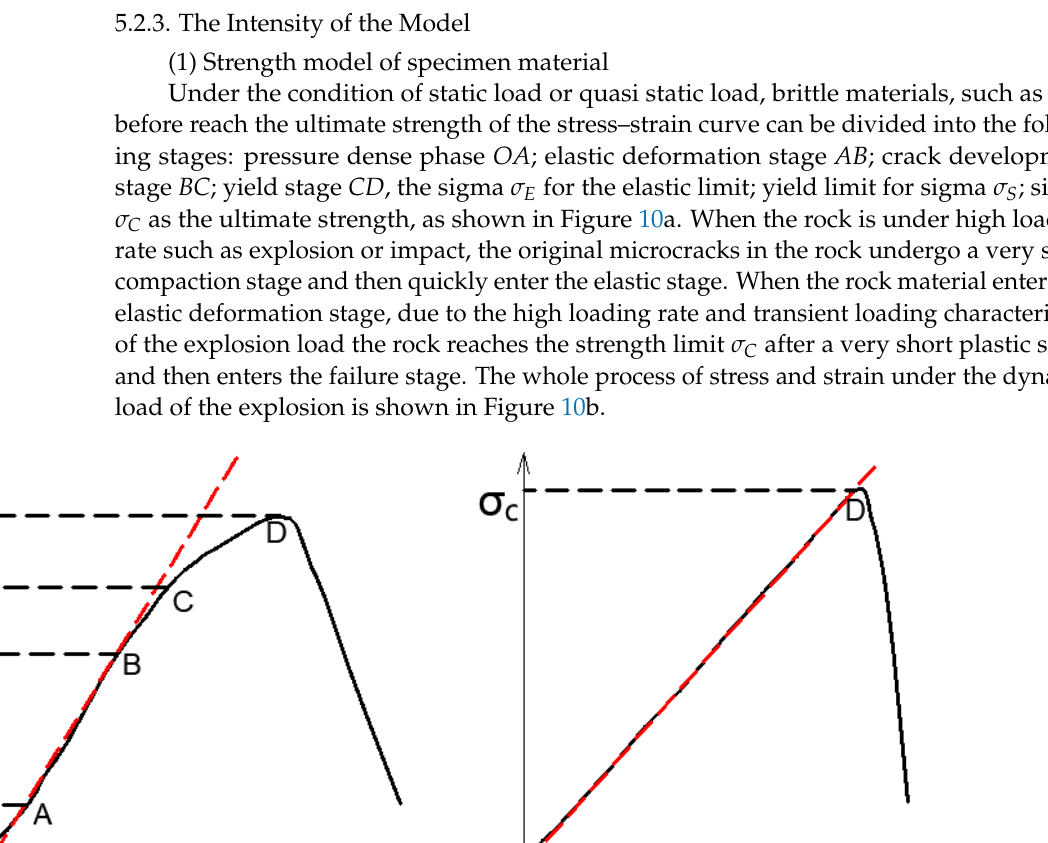
Figure 9. JWL equation pressure and relative volume number function diagram.